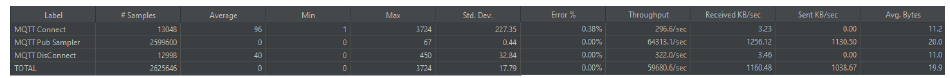
Table 8. Test results during 10 times of repetition.